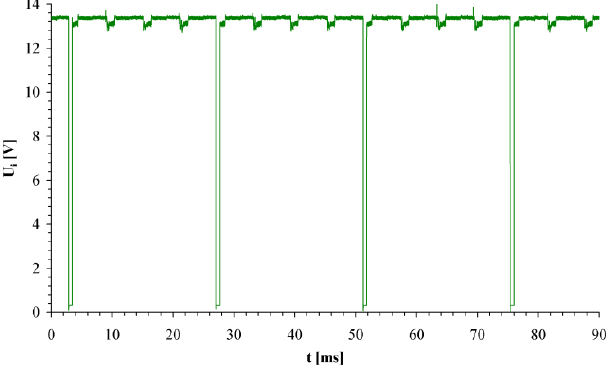
Fig. 2. An example of a binary signal with an amplitude exceeding 5